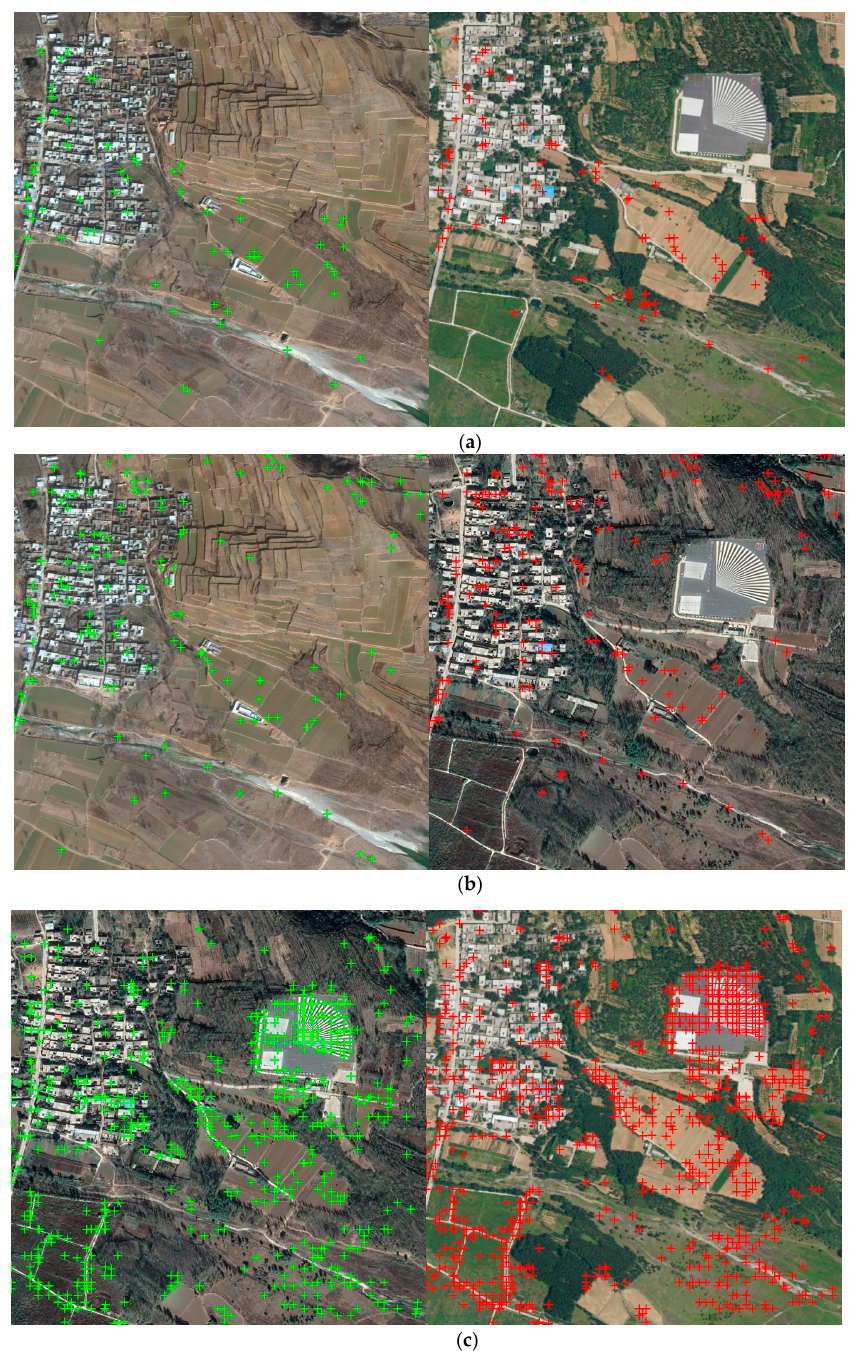
Figure 8. Multi-source image matching based on the Google reference image. ( a ) Case 8: Image matching with significant ground object difference; ( b ) Case 9: Image matching with different sensors, seasons and times; ( c ) Case 10: Image matching with different sensors and times.